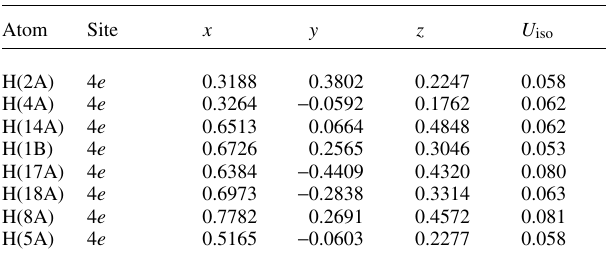
Table 2. Atomic coordinates and displacement parameters (in Å 2 )